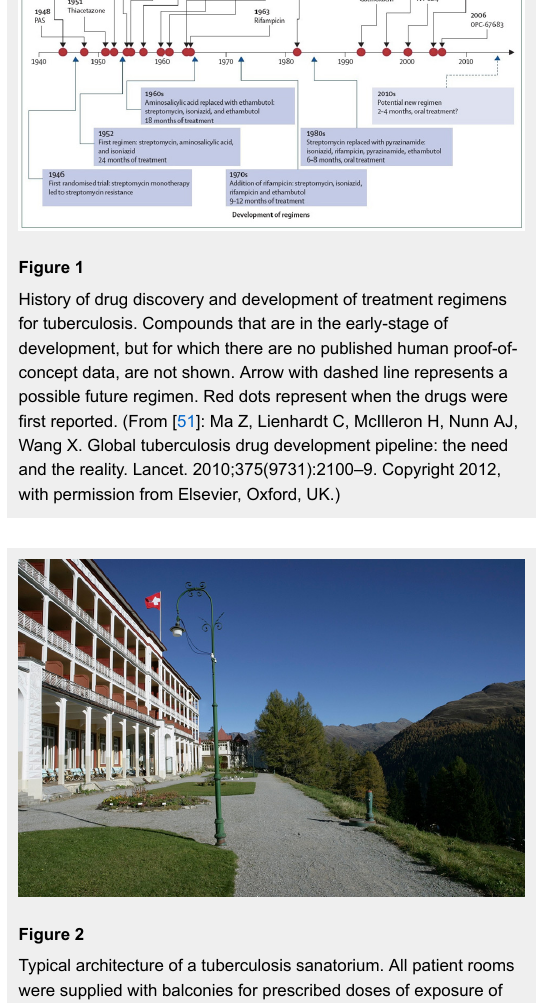
Typical architecture of a tuberculosis sanatorium. All patient rooms were supplied with balconies for prescribed doses of exposure of patients to sunlight and fresh air, which was believed to be beneficial at the time (Sanatorium Schatzalp, Davos, Switzerland). (Copyright by Davos Tourismus, Switzerland [swiss-image.ch/ Christof Schuerpf], with